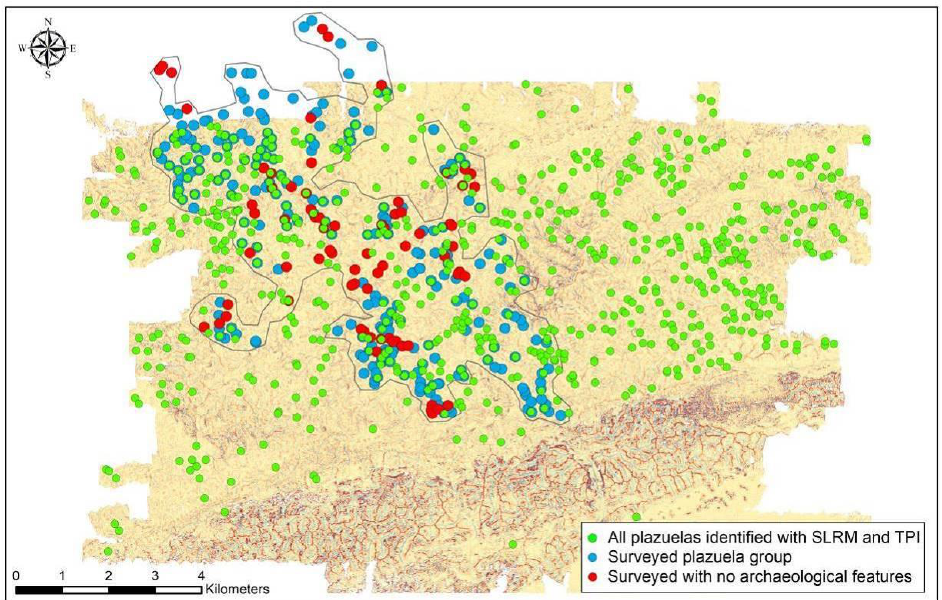
Figure 7. The location of all the plazuelas identified with SLRM and TPI (green dots), compared to plazuelas documented during pedestrian survey (blue dots) and hilltops with no archaeological features documented during pedestrian survey (red dots). Pedestrian survey boundaries are indicated by the gray outline. The background is the TPI raster.